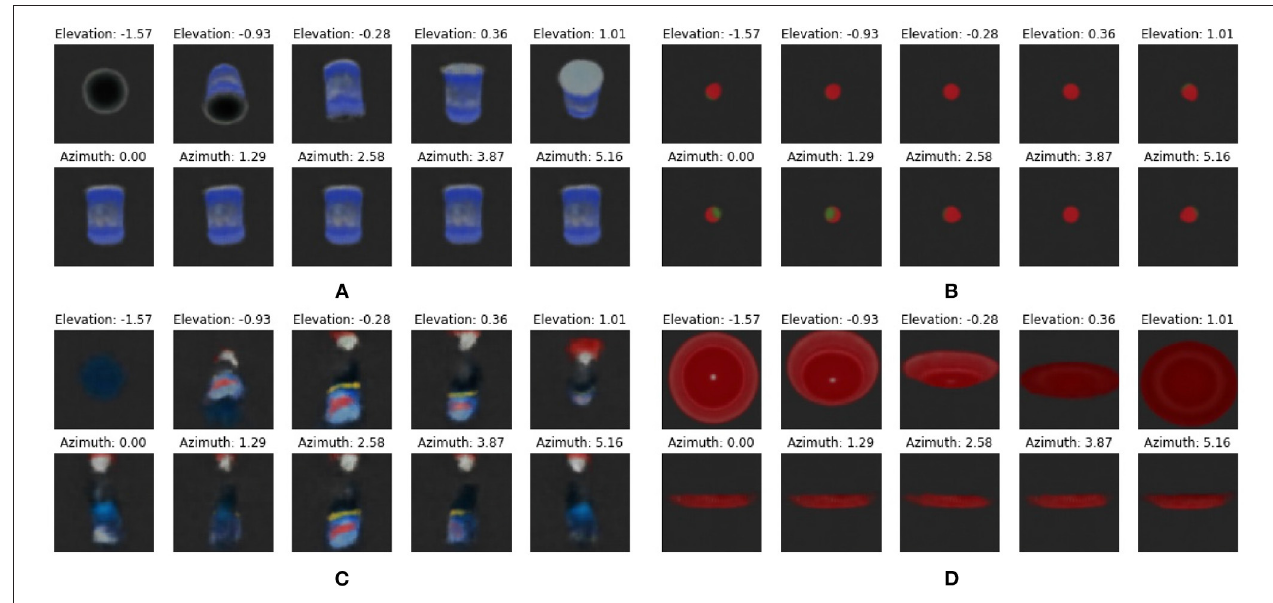
FIGURE 9 | Imaginations generated from CCN models of (A) master chef can, (B) strawberry, (C) windex bottle, and (D) plate. We vary a single dimension while keeping the other three at a fixed position. The top row shows a varying elevation and the bottom row shows a varying azimuth, within the full range as defined in Section